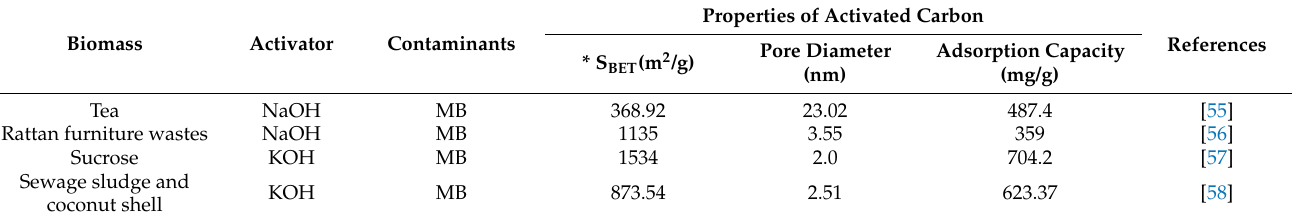
Table 2. Source of biomass, chemical activator and structural properties of activated carbon and adsorption